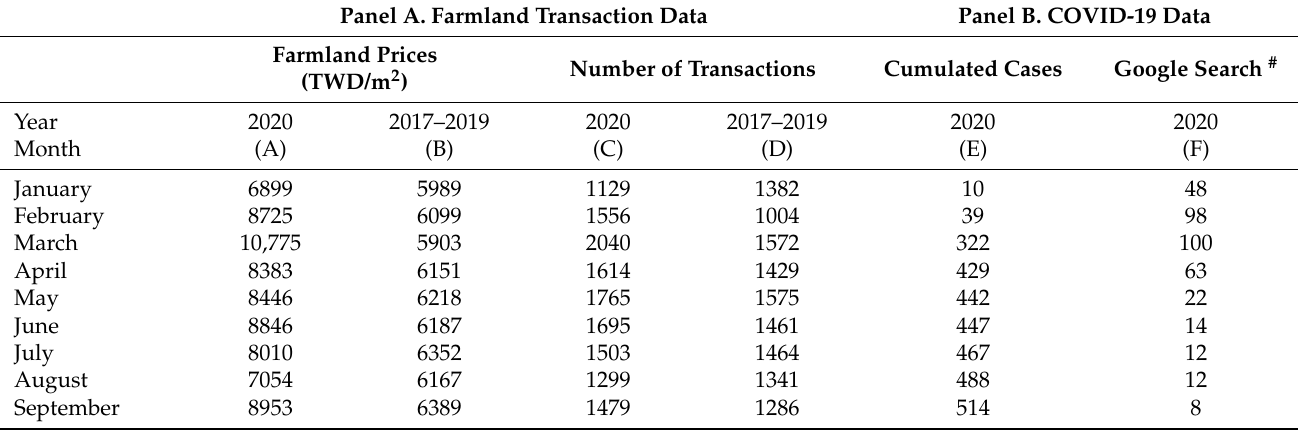
Table 1. Sample statistics of farmland prices over time. Panel A. Farmland Transaction Data Panel B. COVID-19